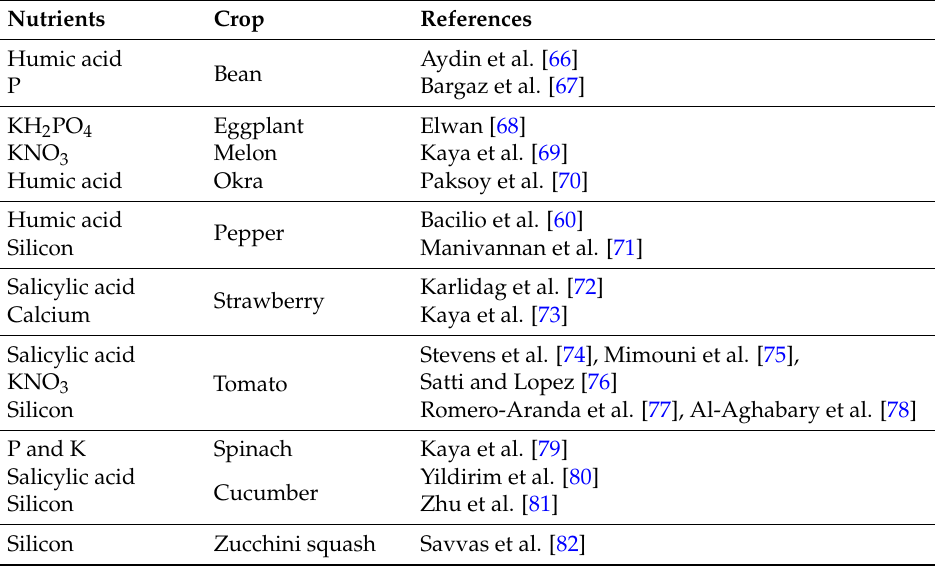
Table 3. Nutrients that improved salt tolerance in different vegetable crops.